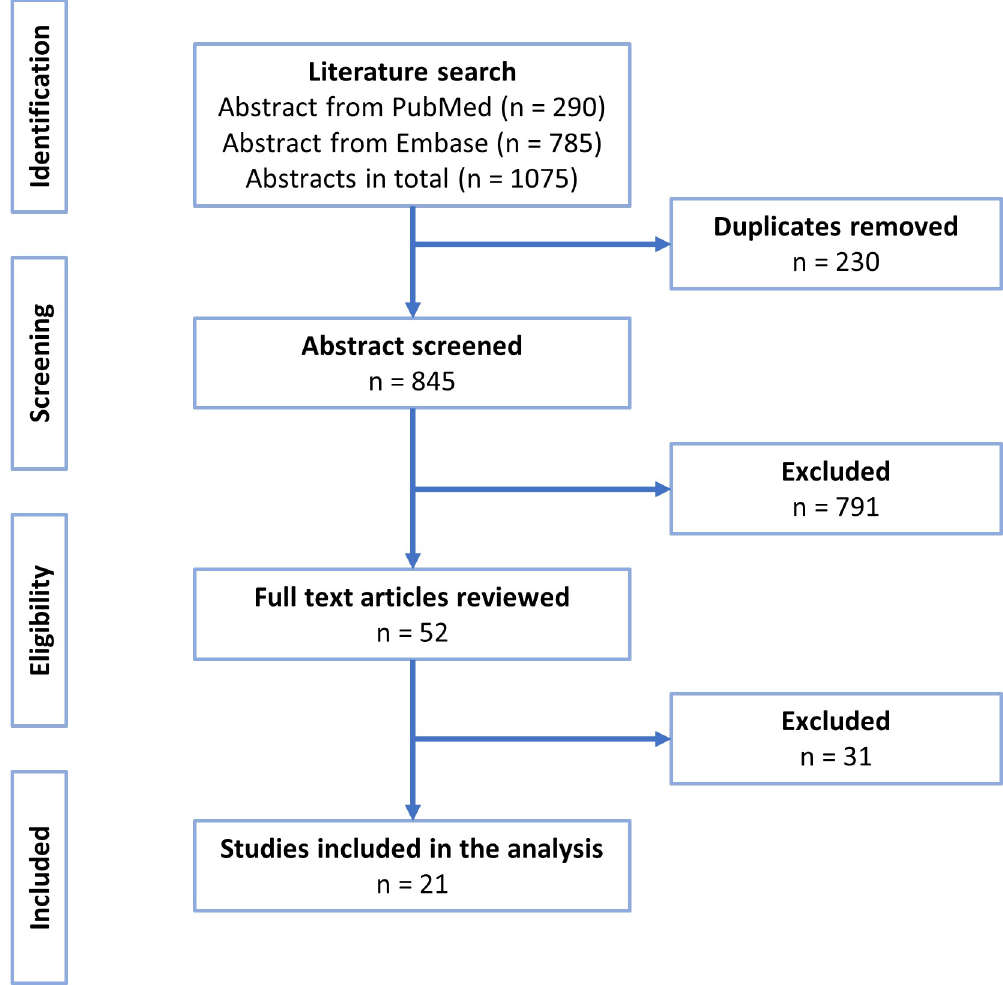
Fig 1. PRISMA flow diagram of study